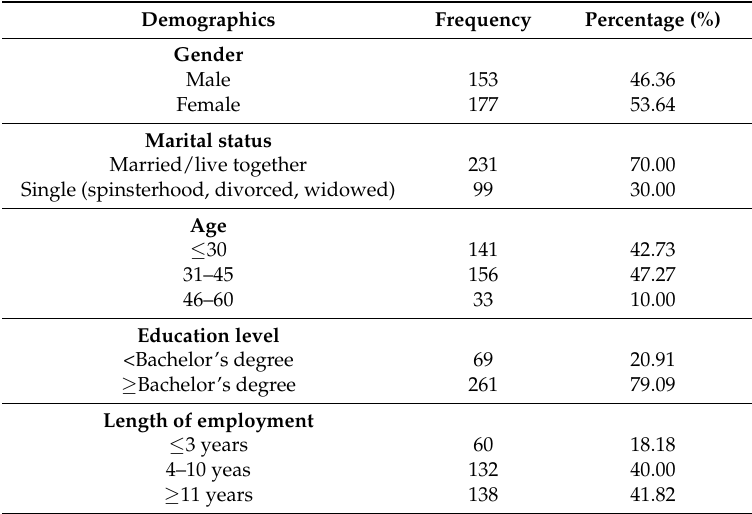
Table 1. Demographic information of the survey participants ( n = 330).